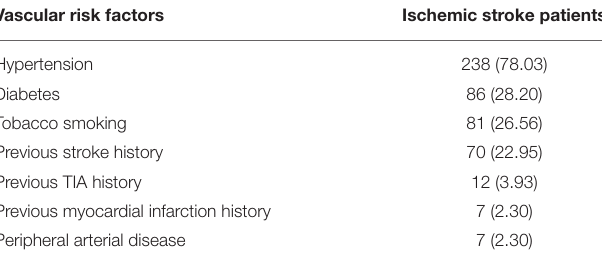
TABLE 2 | Vascular risk factors of ischemic stroke patients ( n = 350).